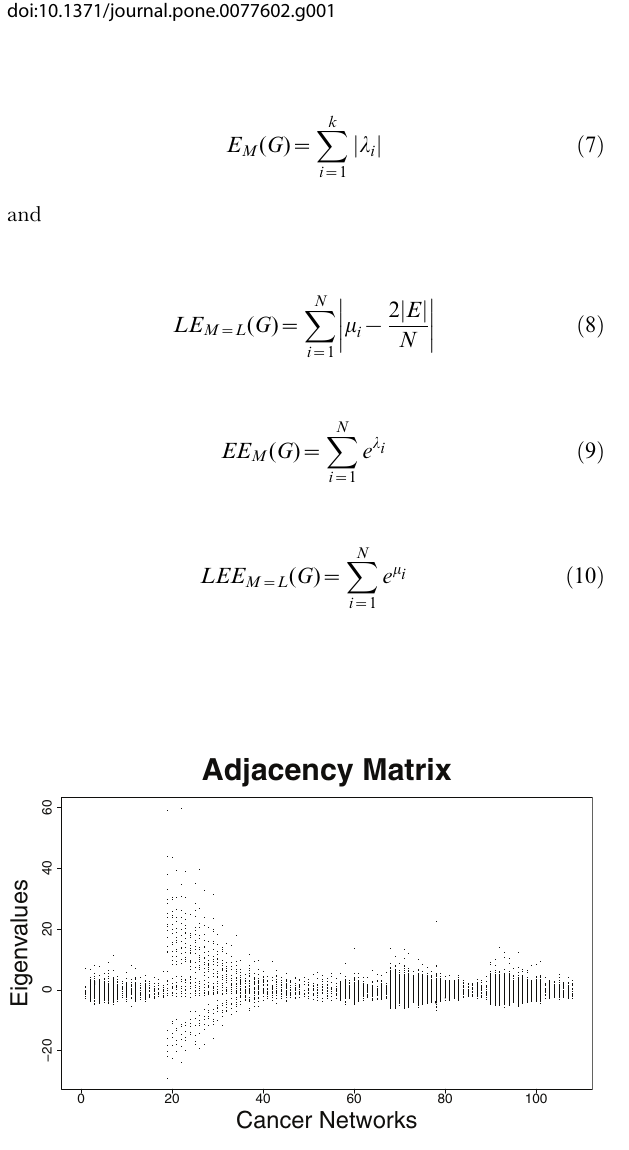
Figure 3. Distributions of the Eigenvalues of the distance matrix for the benign networks.